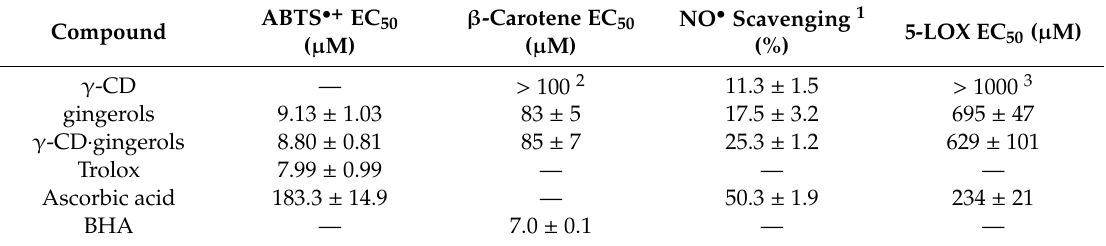
Table 4. Inhibition of 5-LOX and radical scavenging activities of the gingerols in the presence and absence of γ -CD, as compared to those of reference